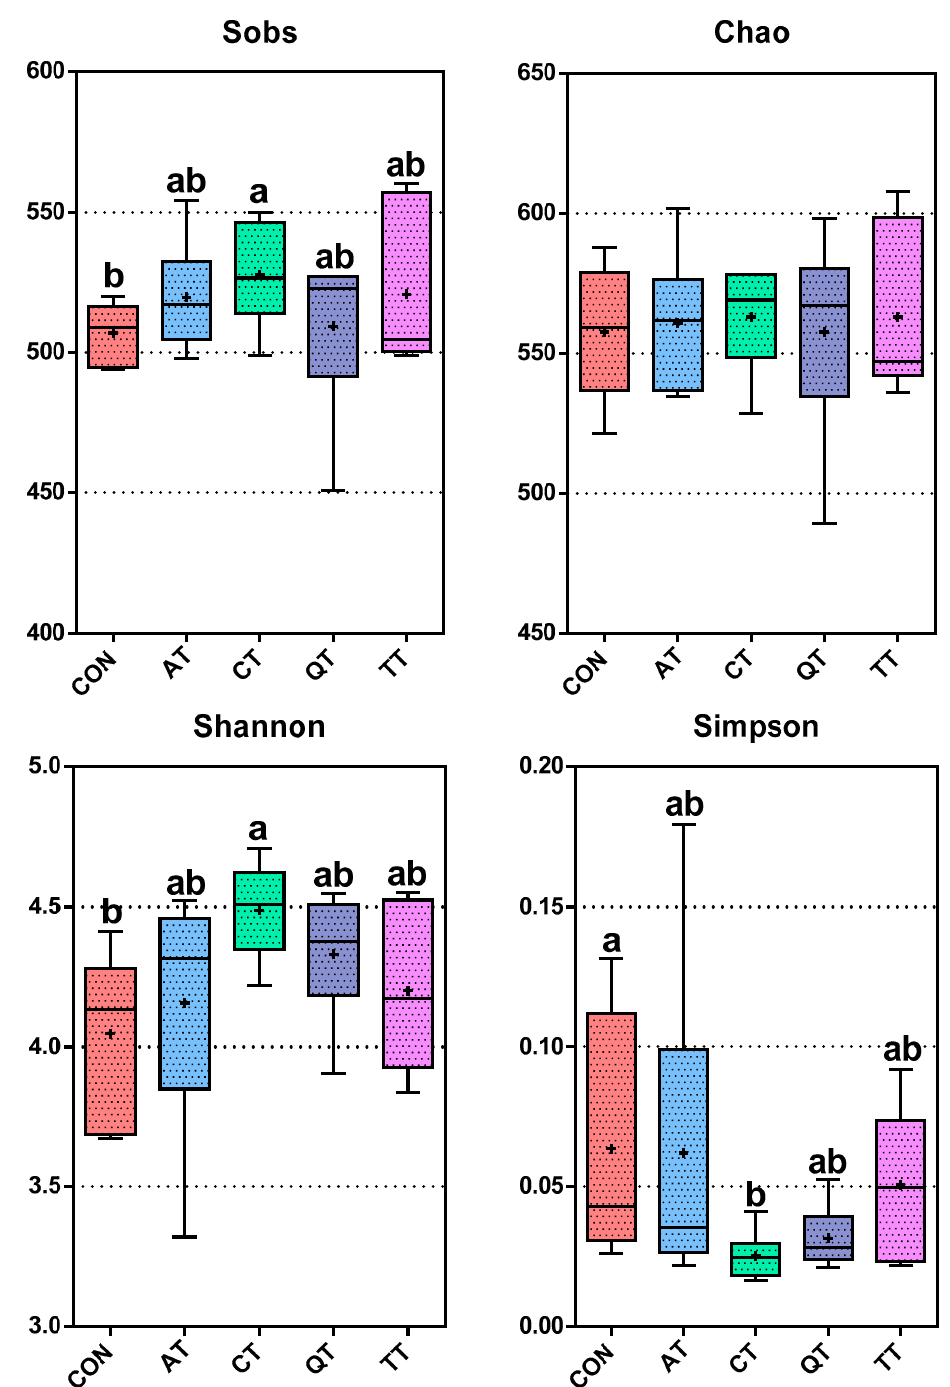
Figure 5. Alpha diversity analysis of gut microbial abundance (Sobs and Chao indices) and diversity (Shannon and Simpson indices) from different groups ( n = 6/group); statistical significance was determined by Mann–Whitney U test for two-group comparisons. Different letters (a and b) indicate significant differences ( p < 0.05), while the same letter indicates no significant differences ( p > 0.05). CON, control; AT, Acacia mearnsii tannin; CT, Castanea sativa tannin; QT, Schinopsis lorenzii tannin; TT, Caesalpinia spinosa tannin.